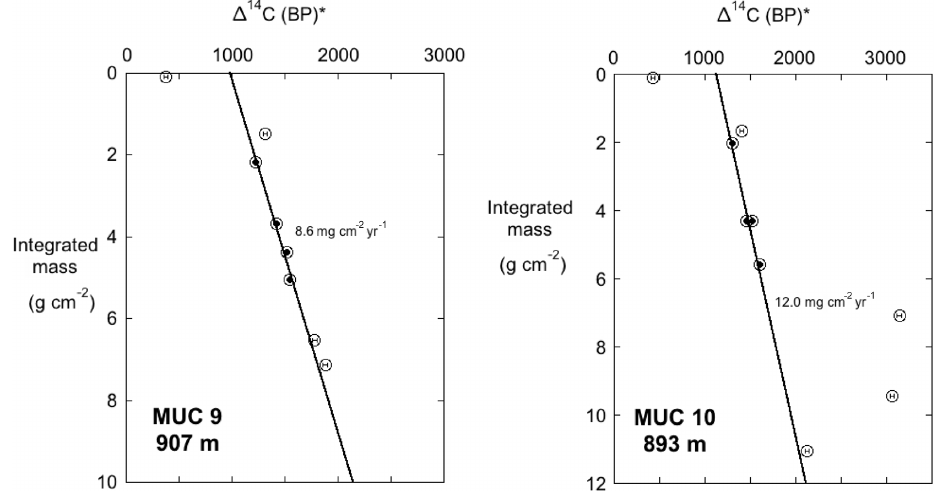
Figure 9. (cid:49) 14 C (BP) ∗ vs. integrated mass (gcm − 2 ) for SMB cores MUC 9 and MUC 10. The (cid:49) 14 C (BP) ∗ value denotes conventional radiocarbon age without assigning a reservoir age. If reservoir age and mass accumulation rate are unchanging, the plots should be linear. A linear fit was applied to the solid circles (between 2 and 6 mass units; 5–18cm depth range). Data from above 2 mass units and below 6 mass units were excluded from the fits, as they appear to be influenced by “bomb” carbon or turbidites (see Fig. 10). The regression slope defines mass accumulation (in mgcm − 2 yr − 1 ). The depth equivalent to 2gcm − 2 represents an age of approximately 120yrBP (approximately 1900